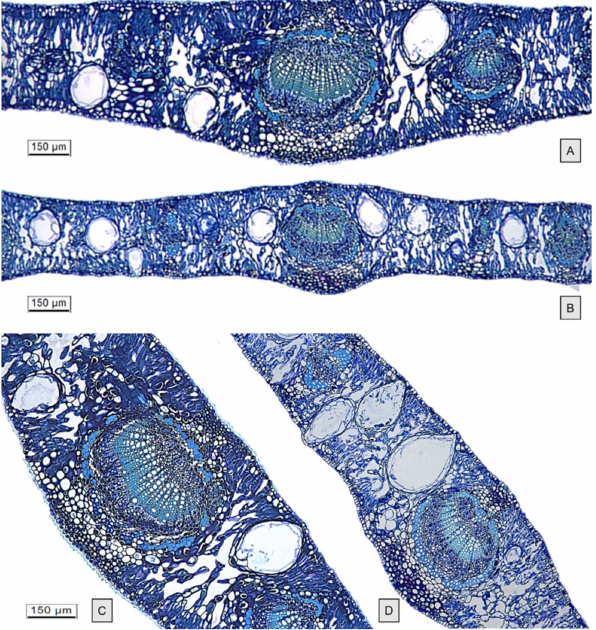
Figure 5. LM—TBO staining. Transverse sections through leaf midrib of E. gunnii (EG) ( A – C ) and E. pulverulenta ‘Baby blue’ (EP) ( B – D ), showing oil cavities varying from spherical/ellipsoidal to